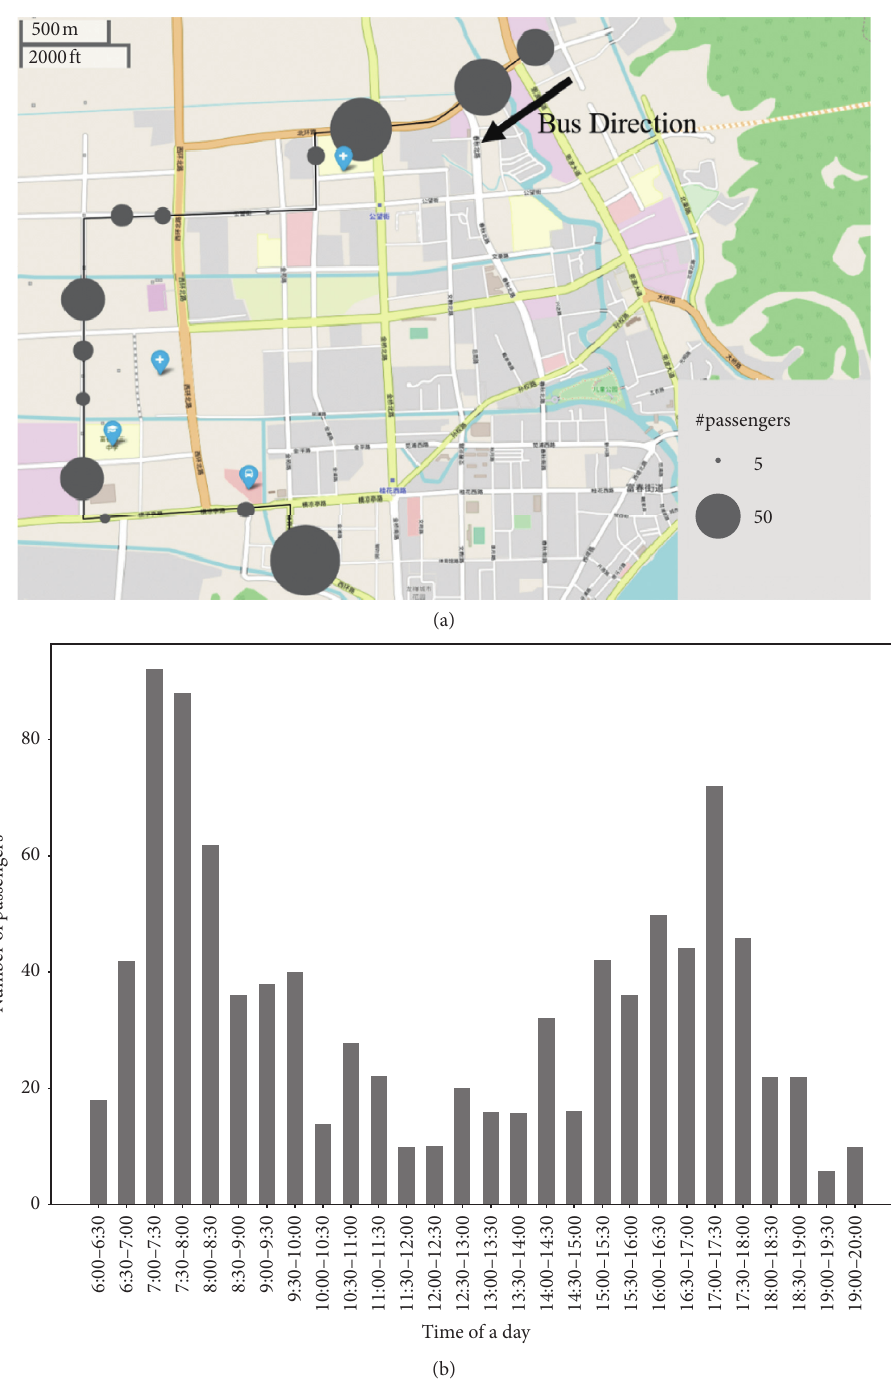
Figure 2: Demand for Bus Line 622. (a) Spatial distribution of bus travel demand. (b) Temporal distribution of bus travel